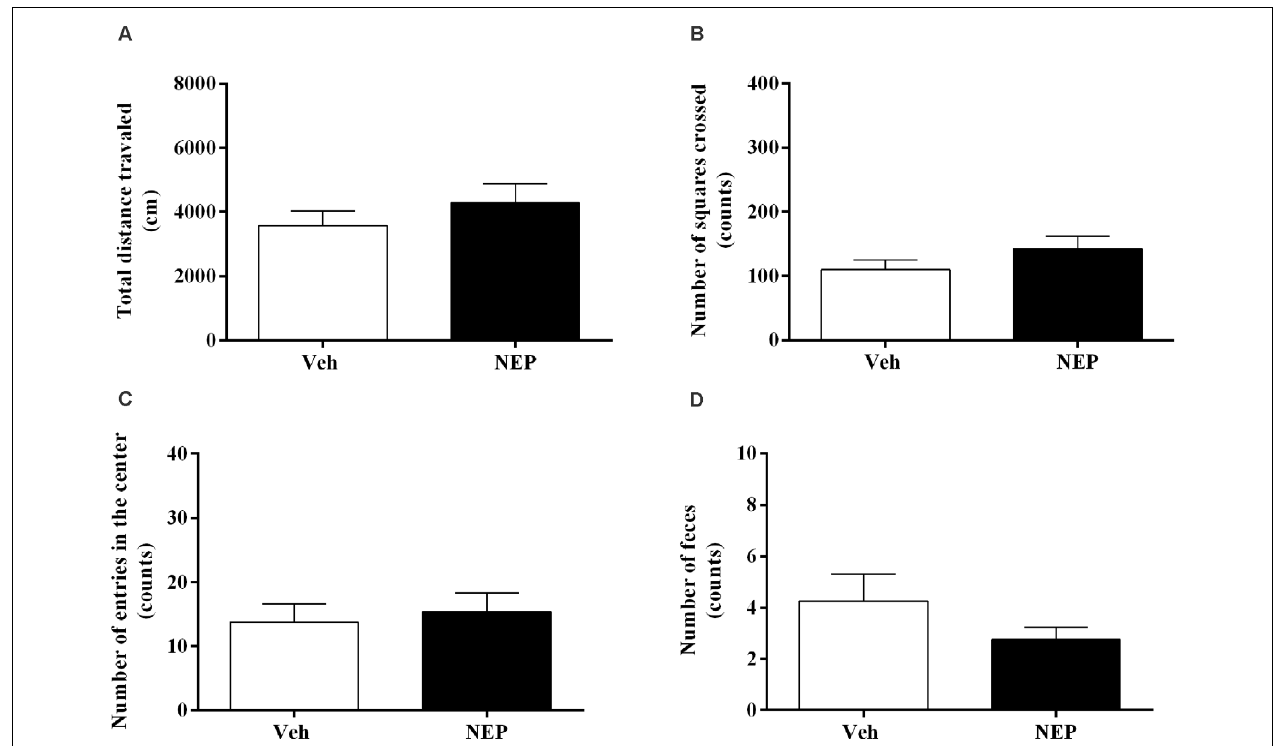
FIGURE 4 | (A) Total distance traveled and number of (B) squares crossed, (C) entries in the center, and (D) feces of the open field test, on day 11 after post-traumatic stress disorder (PTSD) induction. Values are means ± SEM of eight mice per group. Veh, mice in the PTSD-group and treated with vehicle; NEP, mice in the PTSD-group and treated with nepicastat.